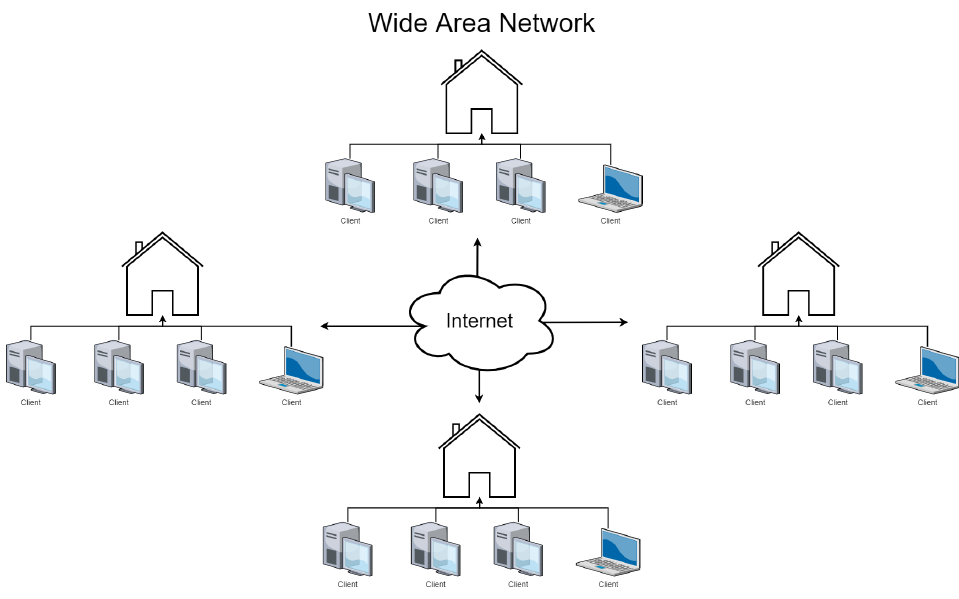
Figure 3. Wide Area Network diagram.